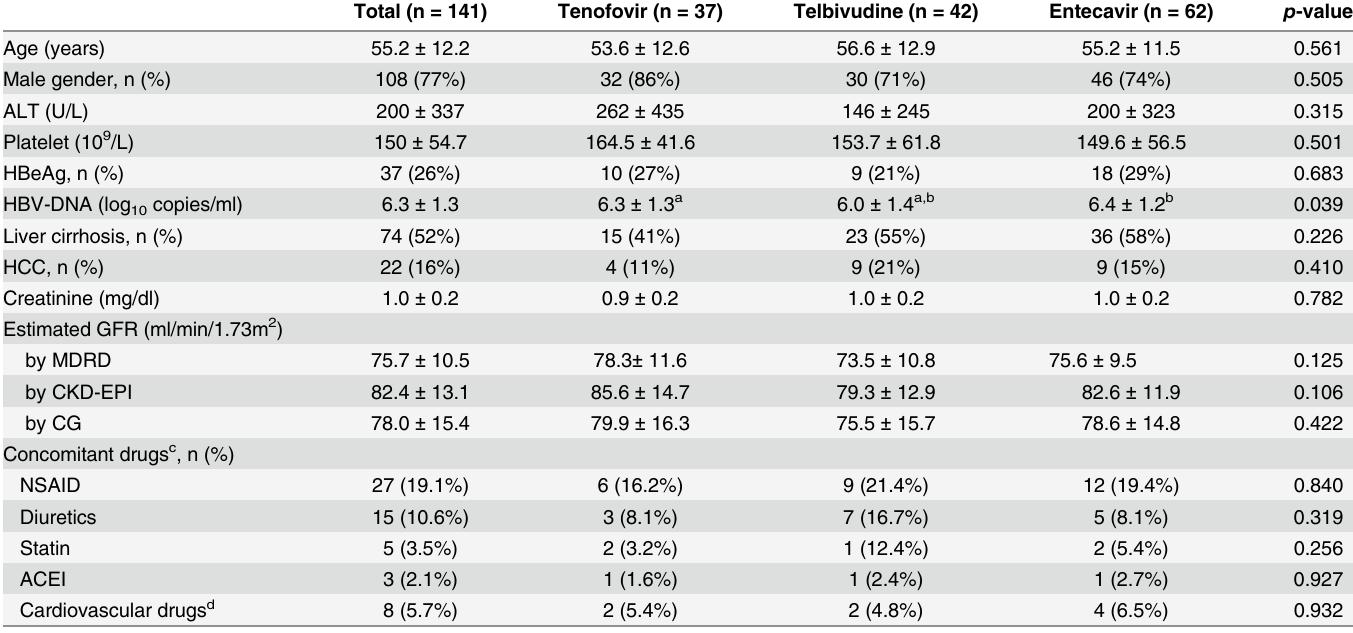
Table 1. Baseline characteristics of the study